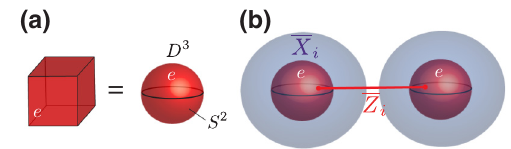
FIG. 17. (a) A cubic hole is topologically equivalent to a 3- ball D 3 with its boundary being the 2-sphere S 2 . (b) An e -hole can trap a logical X -brane and let a logical Z -string terminate on it due to condensation of e -anyons on its e -boundary. A pair of e -holes can encode a single logical qubit, similar to the situation of the 2D surface code in Fig.